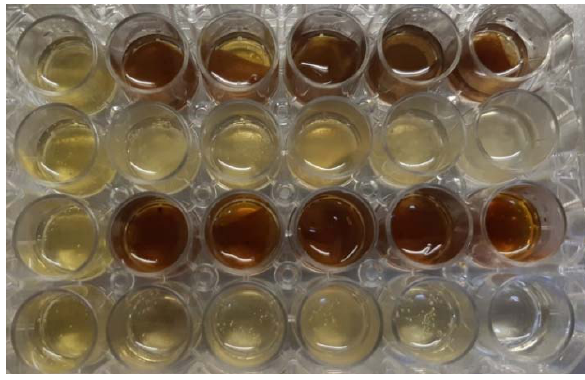
Figure 4. Well plates with samples